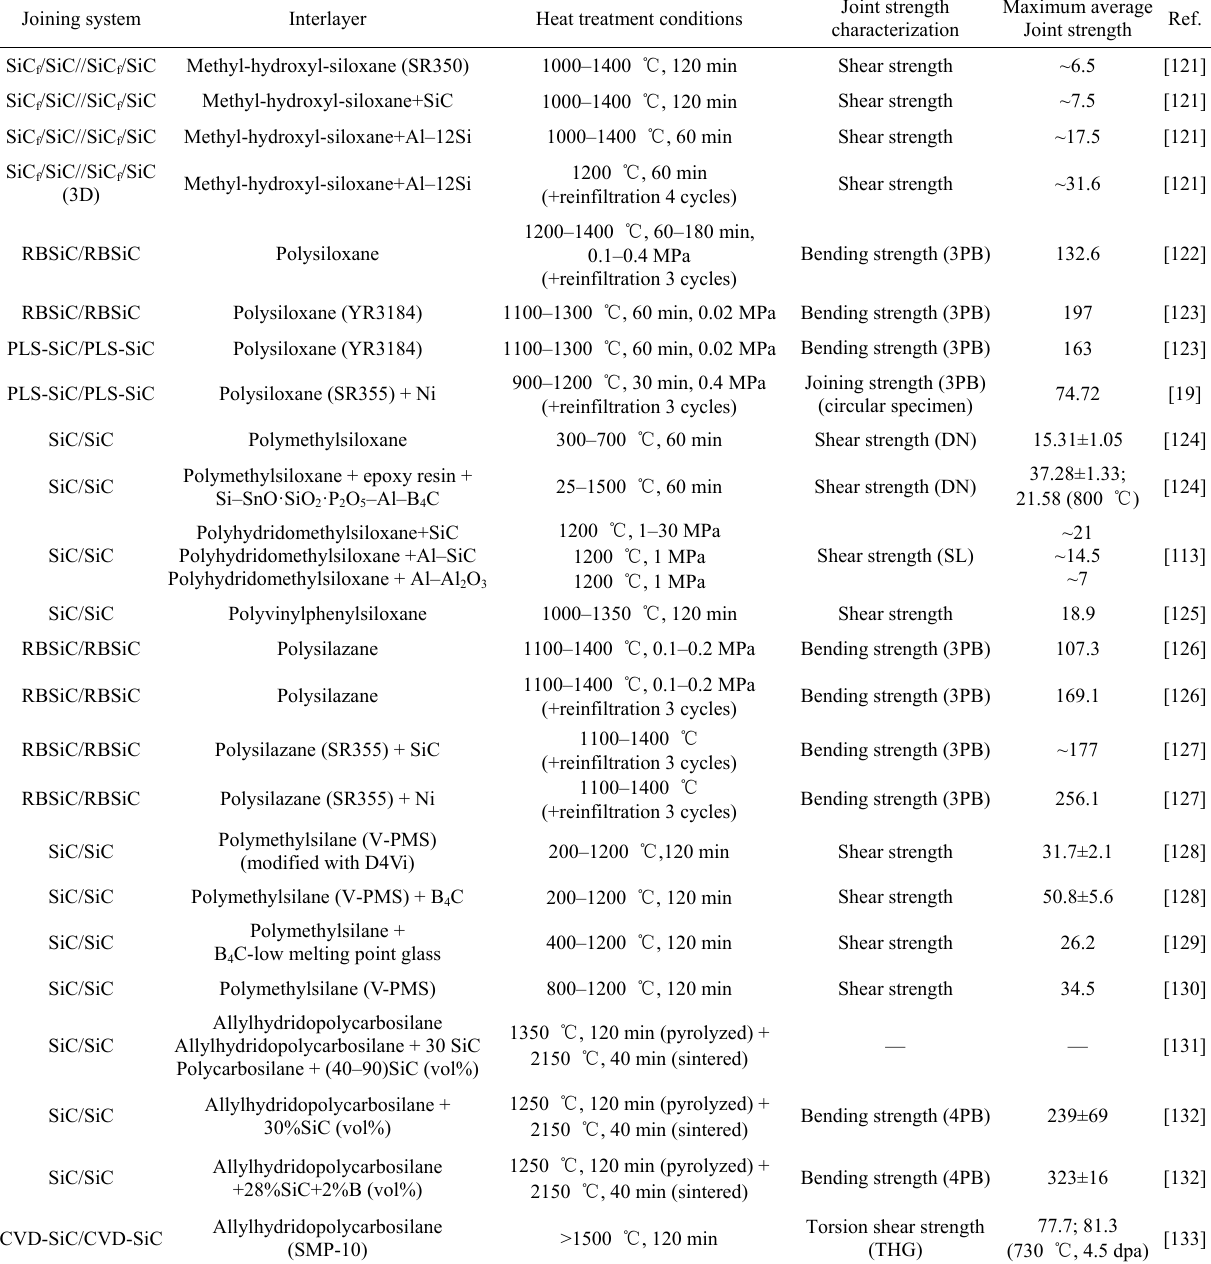
Table 9 Joining of SiC-based materials using organic (+additives) interlayer: interlayer, heat-treatment process, and joint